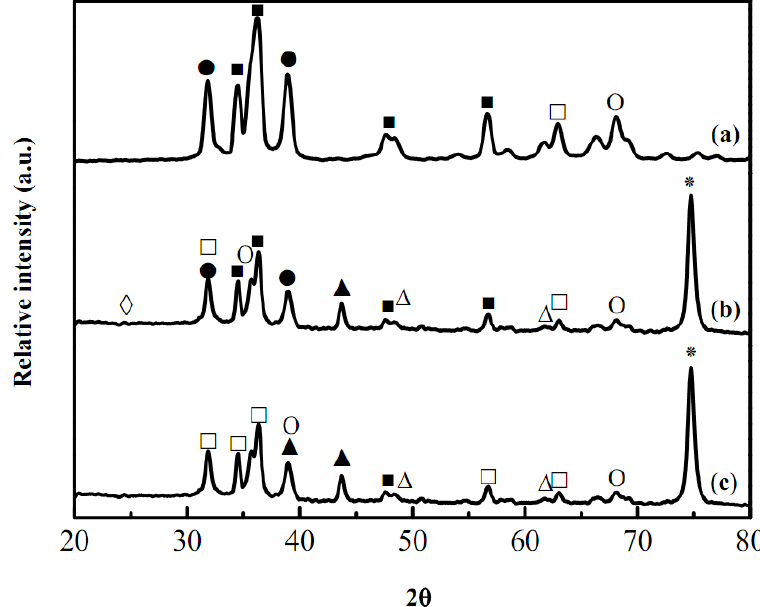
Figure 3. XRD patterns of washcoat catalysts coated mixed with ZrO synthesized CuO/ZnO-Al foil of (a) fresh as-synthesized CuO/ZnO-Al after calcinations at 623 K; ( ● : Cu; O: CuO; ■ : Zn; □ : ZnO; ▲ : CuAl ◊ : ZrO ; *: SUS 2